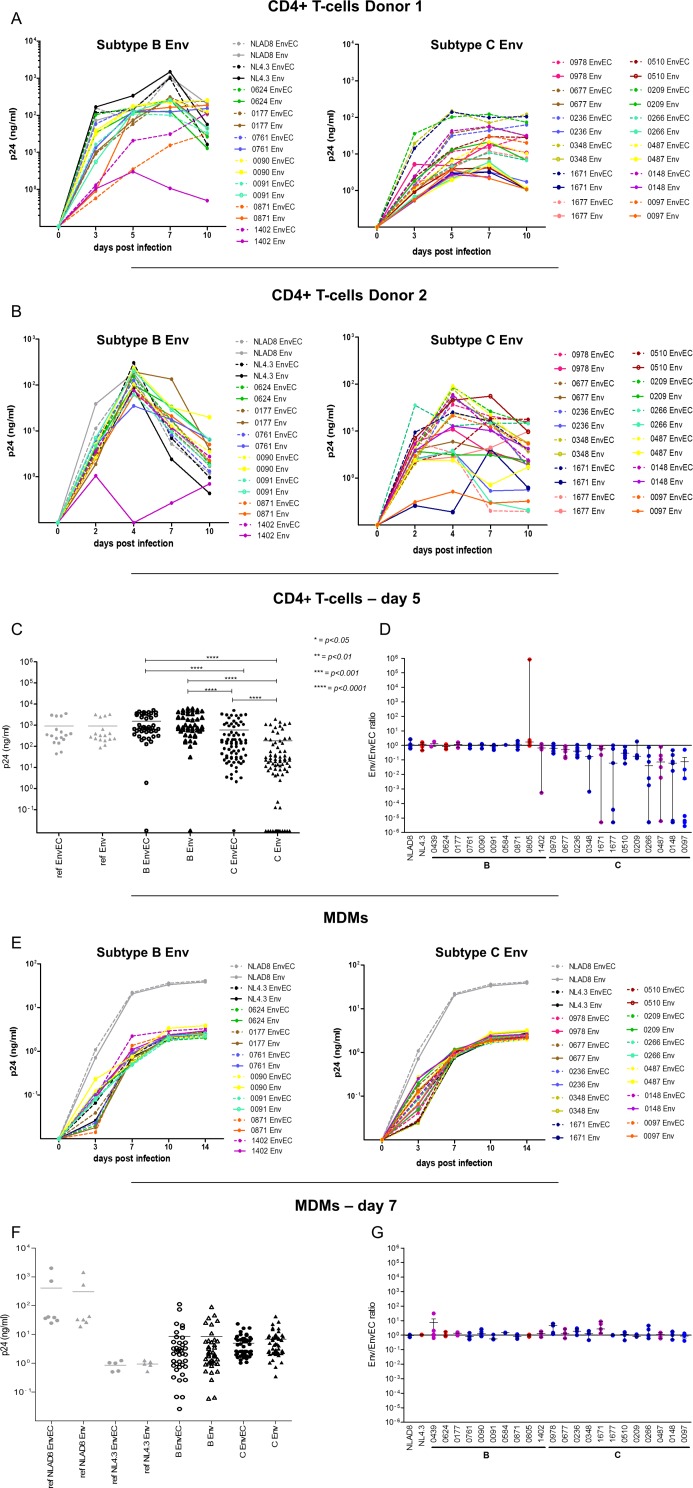
Viruses with subtype C gp41CT have lower replication than viruses with subtype B gp41CT in CD4+ T-cells but not in MDMs.A and B. Replication of subtype B and subtype C recombinants in CD4+ T-cells from two different donors. 105 CD4+ T-cells were infected with equivalent amounts (1 ng/ml) of Env or EnvEC recombinant viruses. Infection was monitored by measuring p24 in culture supernatants at days 2 or 3, 4 or 5, 7 and 9 or 10. Examples of replication in CD4+ T cells of two different donors are shown after infection with subtype B (left panels) and subtype C (right panels) Env and EnvEC recombinant viruses. All infections were performed in triplicate wells. (C and D) P24 in supernatants of 105
CD4+ T-cells 5 days post-infection. The same results at day 5 post-infection are presented and statistically significant means (paired t-test for viral pairs, unpaired t-test for inter-subtype comparisons) are indicated (C). In panel (D), the results are shown per pair. The ratio of p24 released in supernatants of cells exposed to Env recombinant viruses divided by p24 in the supernatants of cells exposed to the corresponding EnvEC recombinant virus is reported. A positive ratio indicates that the full Env recombinant replicates better than its EnvEC counterpart containing the gp41CT of NL4.3. A negative ratio implies the EnvEC recombinant virus replicates better than the Env recombinant. Because of inter-donor variability, results are presented as individual experiments performed with CD4+ T-cells from independent donors. E. Replication of subtype B and subtype C recombinants in MDMs. 105 MDMs were infected with equivalent amounts (3 ng/ml) of subtype B (left panel) and subtype C (right panel) Env and EnvEC recombinant viruses. Infection was monitored by measuring p24 in culture supernatants at days 3, 7, 10 and 14. All infections were performed in triplicate or quadruplicate wells. (F and G) p24 in supernatants of 3x105
MDMs 7 days post-infection. All infections were performed in triplicate or quadruplicate wells. Standard deviation is indicated. In panel (G), the same results as in panel (F) are represented for each individual strain. The ratio of p24 released in supernatants of cells exposed to Env recombinant viruses divided by p24 in the supernatants of cells exposed to the corresponding EnvEC recombinant virus is reported. Tropism is indicated as follows: R5: blue circle; X4: red circle; R5X4: purple circle.